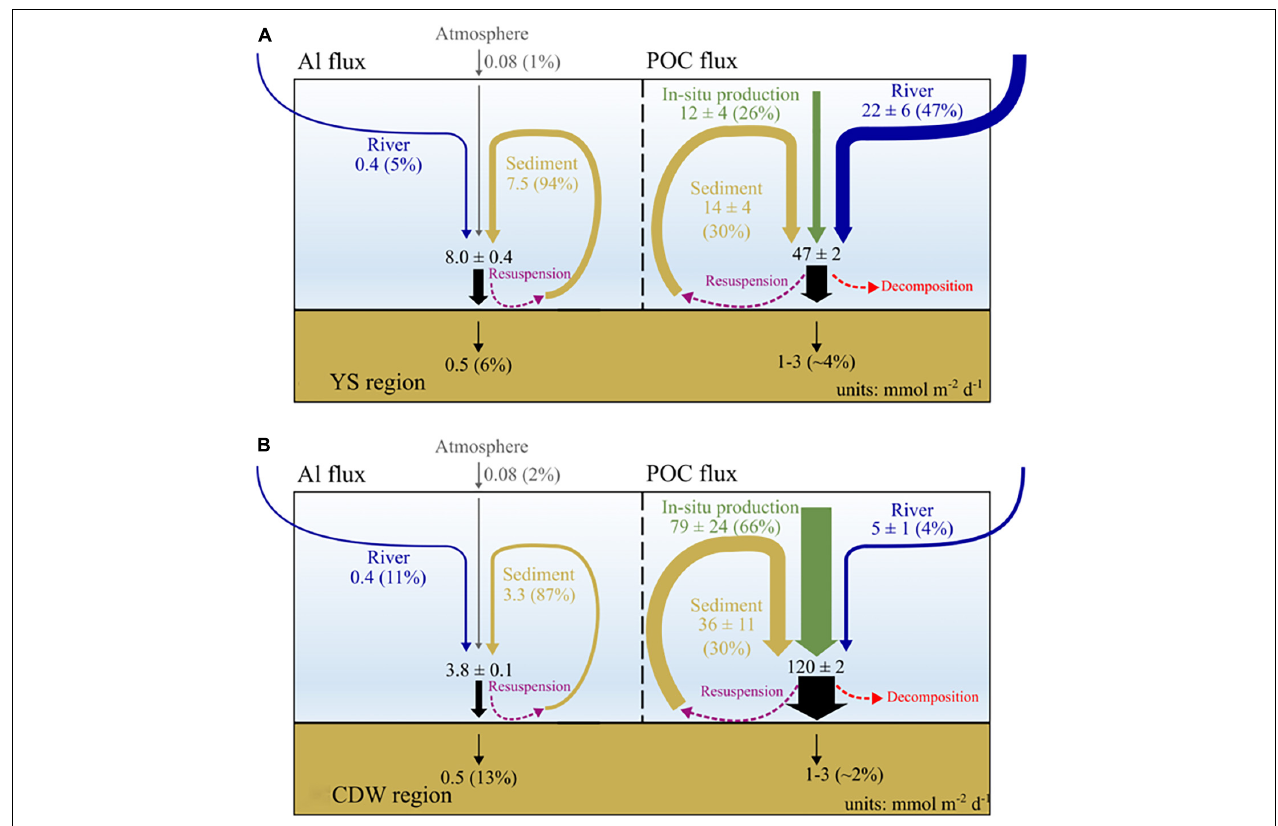
FIGURE 7 | Schematics of Al and POC fluxes in (A) the Yellow Sea (YS) and (B) the Changjiang Diluted Water (CDW) regions. Riverine input of particulate Al was estimated as the difference between the burial flux and atmospheric input. Uncertainties in the in situ production, riverine input, and sediment fluxes are assigned as ± 30%, unless mentioned otherwise, based on the ranges of the endmember values in the source-apportionment calculations.